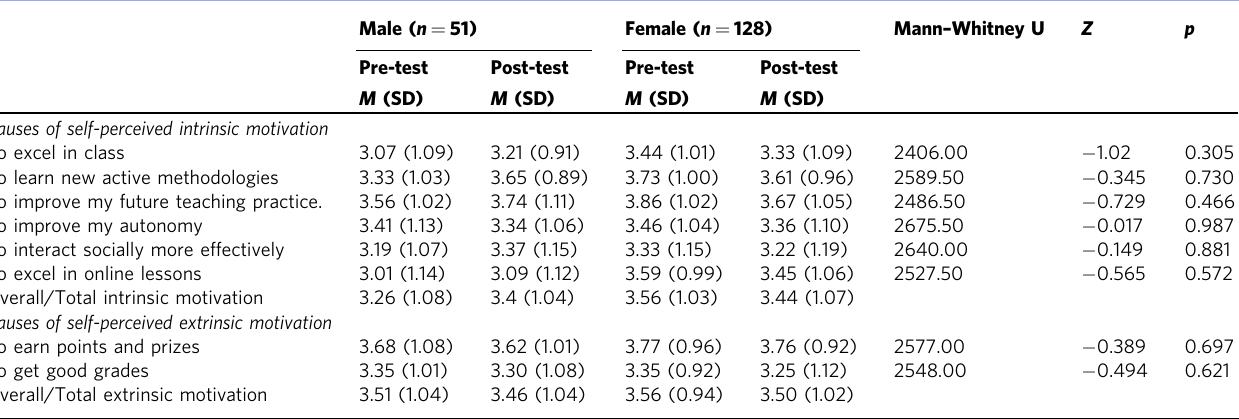
Table 1 Descriptive statistics for the variables referring to self-perceived motivation in this approach during the COVID-19 pandemic according to the gender of the participants.